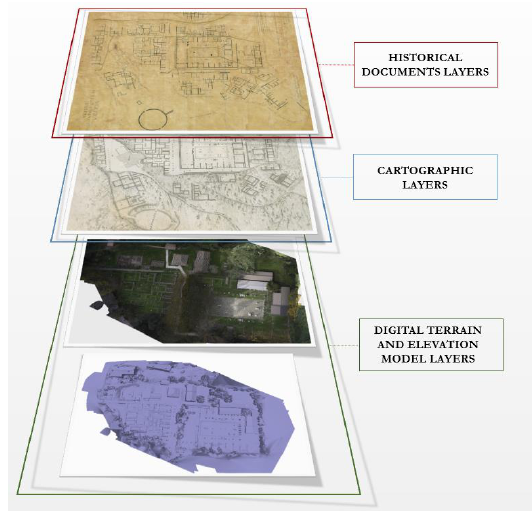
Figure 5. The structure of the Veleia GIS.